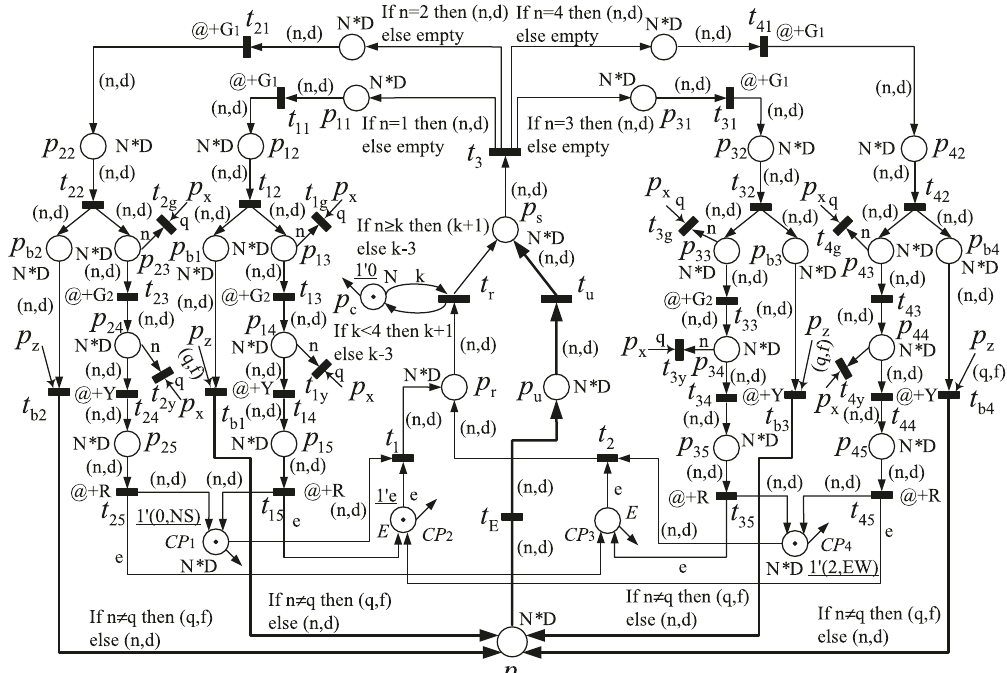
Figure 4: TCPN model of signal display and phase